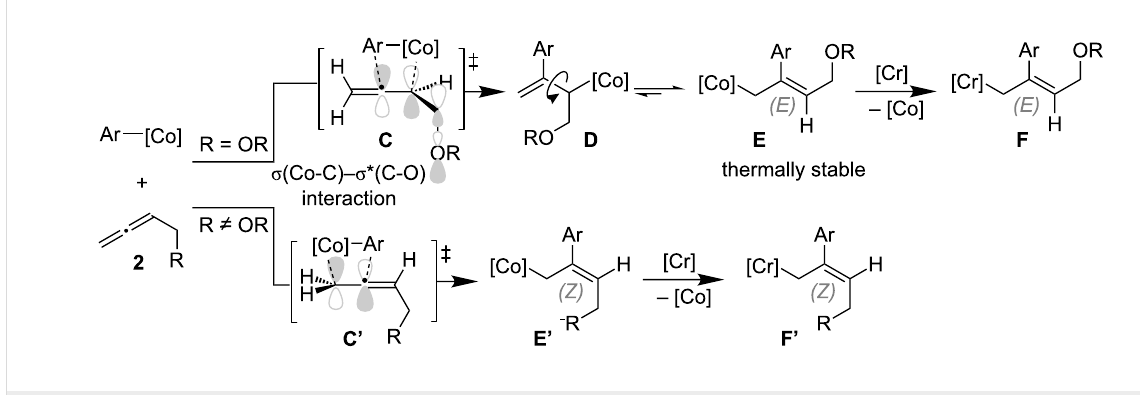
Scheme 11: The origin of the diastereoselectivity in the present three-component coupling.